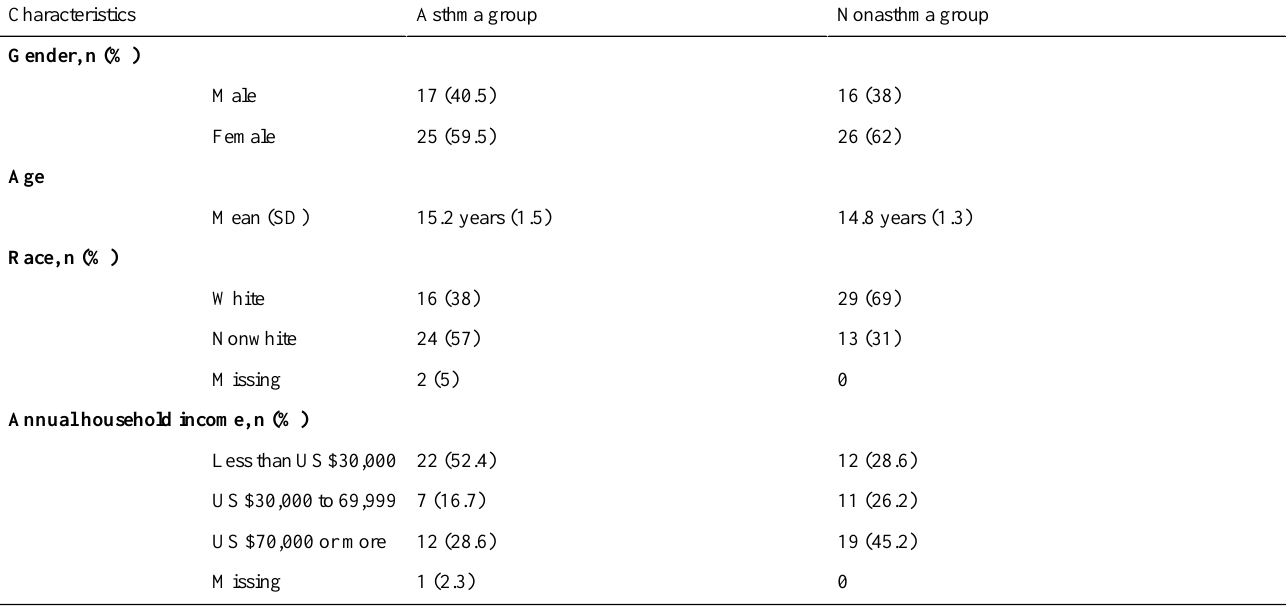
Table 2. The demographic characteristics of the asthma and nonasthma groups in Phase 2 (N=84).